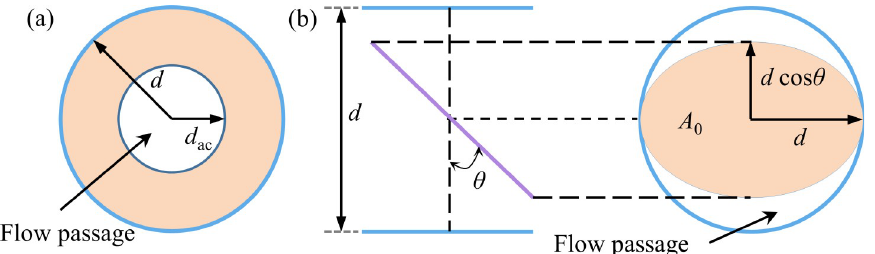
Fig 2. Valve structure parameters. (a) Air-ring flow regulating valve. (b) Center butterfly valve.